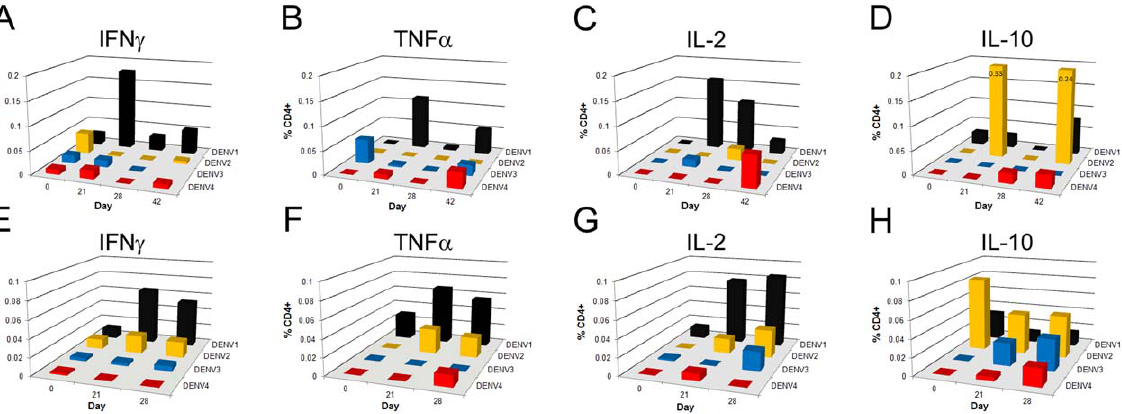
Figure 4. Little T cell crossreactivity when stimulated with heterologous DENV antigens. Cytokine production in CD4 + T cells for 2 subjects (Subject 06, viremic ( A–D ) and Subject 08, non-viremic ( E–H )) in response to stimulation with homologous (DENV-1, black bars) or heterologous stimulation with DENV-2 (yellow), DENV-3 (blue) or DENV-4 (red). Shown are the % CD4 + T cells producing a particular cytokine at pre- vaccination (day 0) and post-vaccination time-points: IFN c ( A, E ), TNF a ( B, F ), IL-2 ( C, G ), and IL-10 ( D, H ). Insufficient cells were available at day 42 for E , F , G , H for analysis.